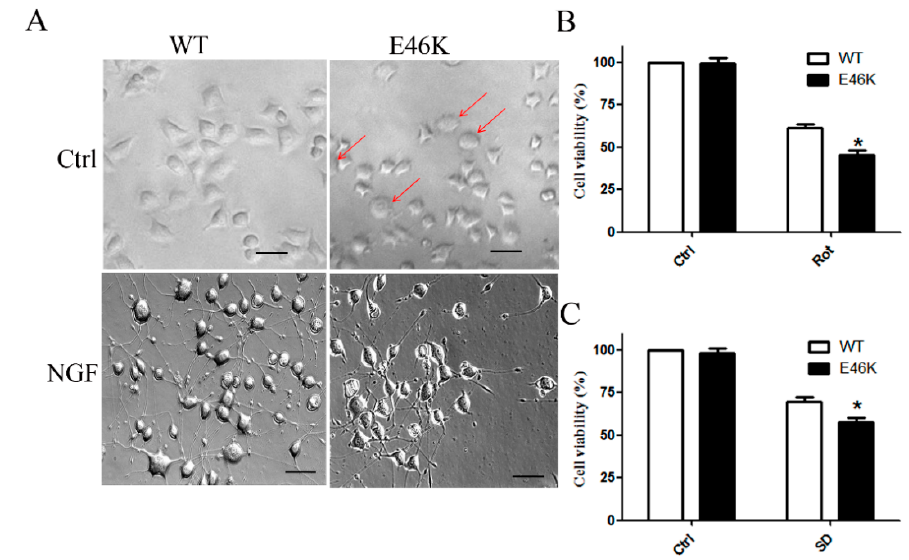
Figure 5. Cells overexpressing E46K mutant α -syn exhibited enhanced vulnerability to apoptosis insults. ( A ) Morphological changes of PC12 cells overexpressing WT and E46K mutant α -syn were observed. The arrowhead indicated abnormal cells. Scale bar: 50 µ m. ( B ) PC12 cells overexpressing WT and E46K mutant α -syn were treated with 10 µ M Rot for 24 h and cell viability was assessed by the MTT assay. ( C ) PC12 cells overexpressing WT and E46K mutant α -syn were treated with serum-free medium for 24 h and cell viability was assessed by the MTT assay. Data were expressed as means ± SD for three independent experiments performed in triplicate. * p < 0.05 when compared with the WT